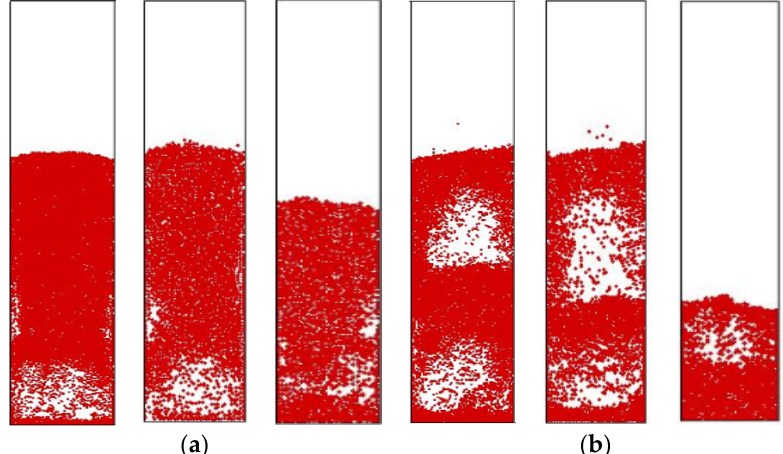
Figure 14. Snapshots of particle distribution obtained by the PCPM at different coarse grain ratio. ( a ) t = 0.40s; ( b ) t = 6.44s. ( a ) l = 1, l = 2, l = 3. ( b ) l = 1, l = 2, l =